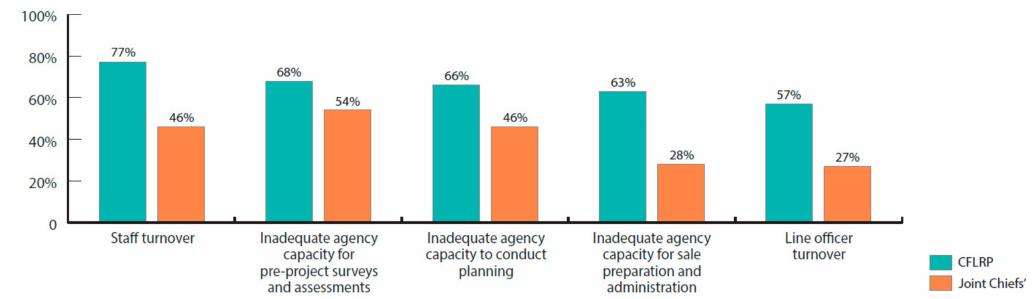
Figure 6. Percent of respondents who said that internal factors were a major challenge or somewhat of a major challenge that hindered project success. Note: The items in the figures were the ones selected by the most participants and do not include all items included in the respective sections of the questionnaire.